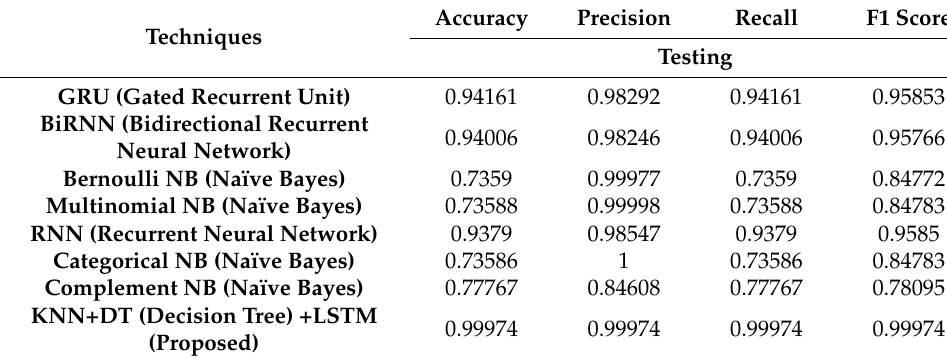
Table 3. Performance Metrics of Different ML/DL Schemes (Test).